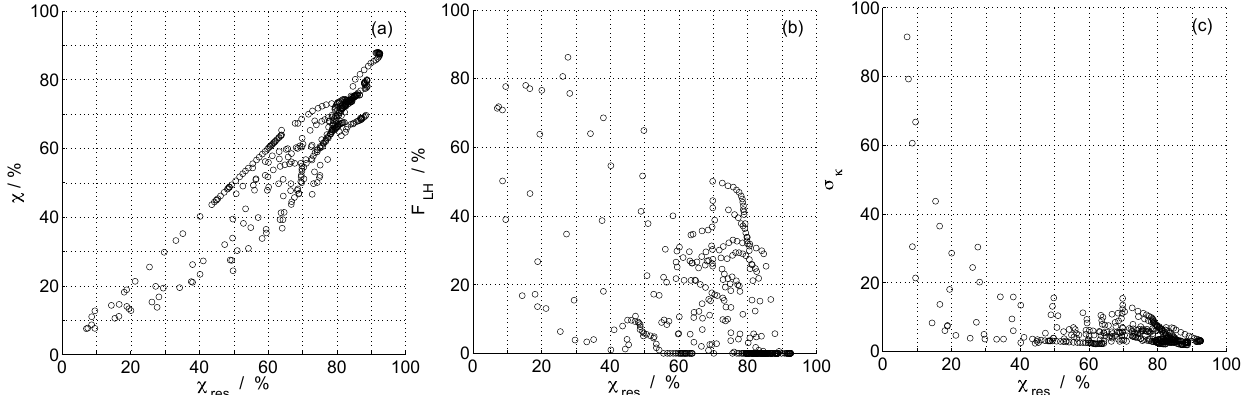
Figure 10. Relationship of (a) size-restricted mixing state parameter χ res and mixing state parameter χ , (b) size-restricted mixing state pa- rameter χ res and number fraction of particles with low hygroscopicity F LH , and (c) size-restricted mixing state parameter χ res and geometric standard deviation of the κ distribution σ κ for all 384 aerosol populations in P .